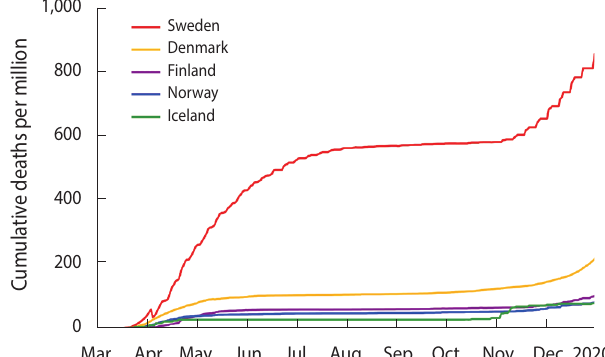
Figure 1. Cumulative deaths per million from COVID-19 among Nordic countries